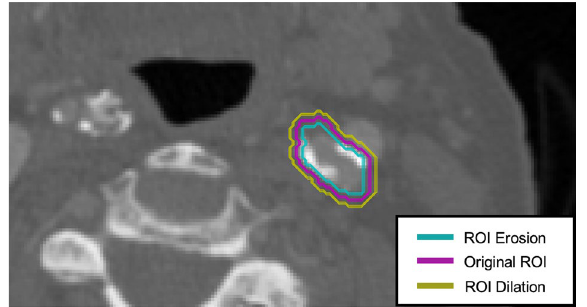
Figure 6. ROI segmentation and perturbations. Carotid CTA images were manually segmented to delineate the carotid artery. The original ROI was subjected to morphological operations: erosions and dilations aimed to assess the robustness of radiomic features to perturbations in image